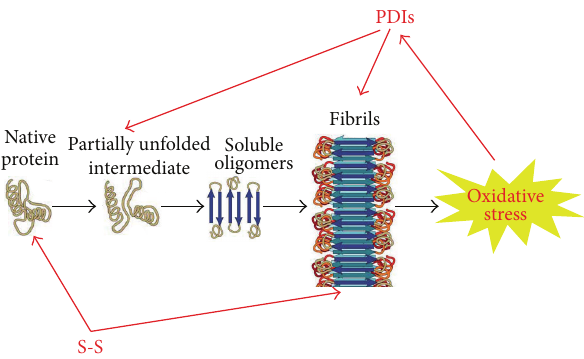
Figure 2: Schematic representation of the role of disulfide bonds (S-S) and disulfide bonding enzymes (PDIs) in the misfolding and aggregation of proteins involved in neurodegenerative misfolding diseases. Disulfide bonds stabilize the monomeric protein slowing downthepopulationofaggregation-proneconformations.Theyalso mediateinmanycasestheformationofaggregatesbyintermolecular disulfide bonds. PDIs, instead, are upregulated in the presence of protein aggregation as a general response to cellular stress and UPR activation. In some cases PDIs also interact specifically with the aggregating proteins or the aggregates. (Adapted from